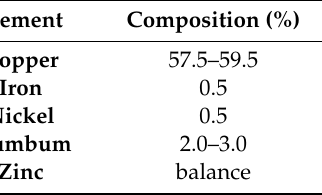
Figure 9. The image of the cutting edge of the diamond tool.